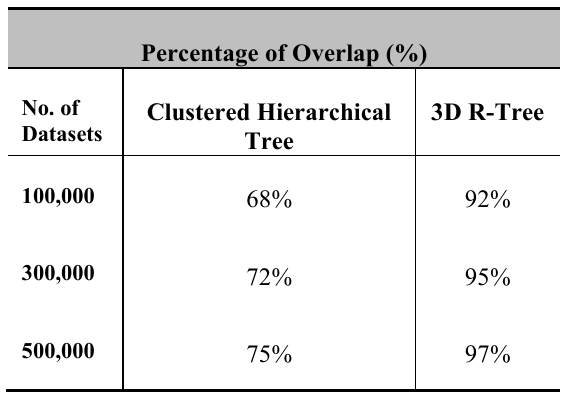
Table1. Overlap percentage analysis for varying number of